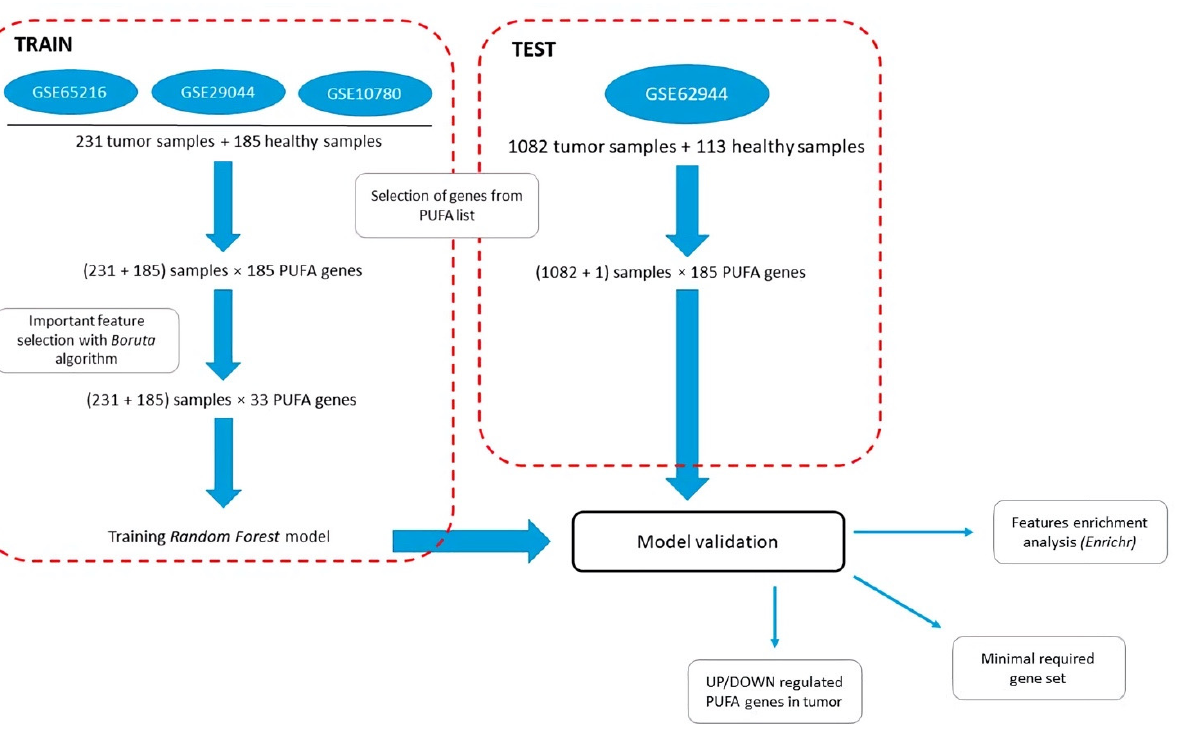
Figure 1. Workflow for studying differences in PUFA regulation between normal and breast cancer samples. Starting from the processed expression matrixes of the corresponding datasets taken from the GEO database, the training and test sets are constructed. To avoid the effect by platform differ- ences, gene expression data within each sample are then converted to the ranks. PUFA genes are selected for the subsequent analysis (See details in the Section 2).